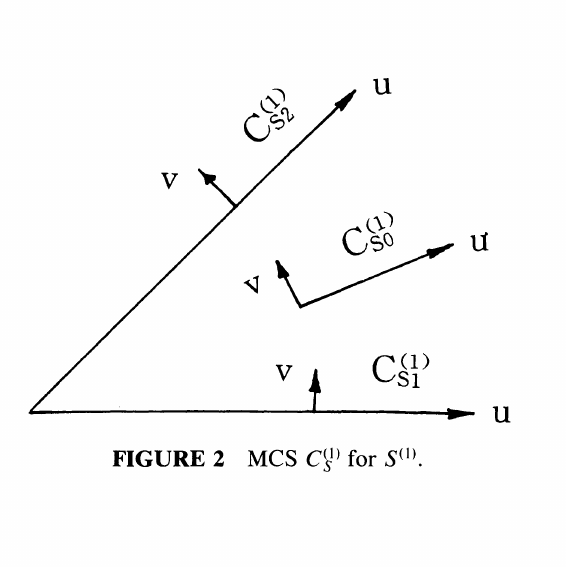
FIGURE 2 MCS C~) for